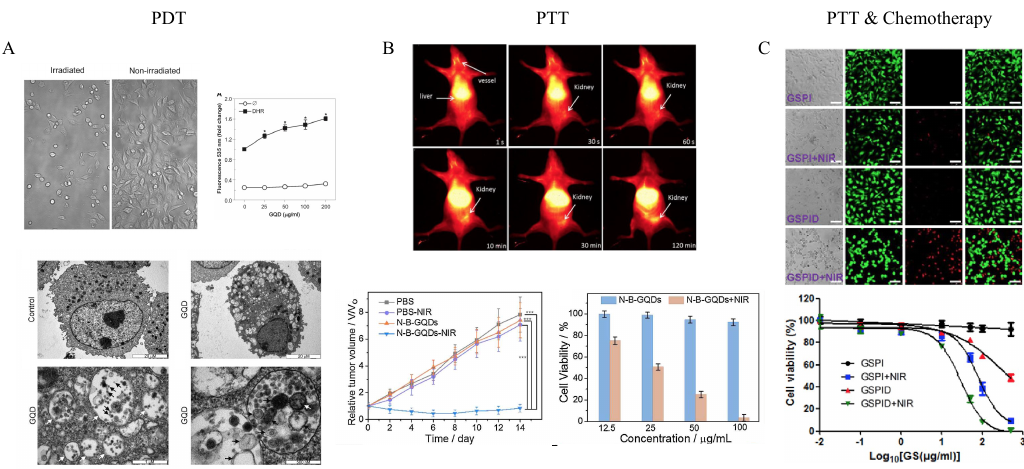
Figure 6. Phototherapy with GQDs. ( A ) Photodynamic therapy by irradiating U251 cells with blue light (470 nm), with relative ROS production (top) and autophagic vacuole formation (bottom, TEM). Adapted from [102]. Copyright 2012, permission from Elsevier; ( B ) NIR-II imaging (top) on xenograft C6 glioma mouse model and photothermal therapy (bottom), showing tumor growth reduction (in vivo) and loss in cell viability (in vitro). Adapted from [100]. Copyright 2019, permission from Elsevier; ( C ) Combination of PTT and chemotherapy with doxorubicin. GSPI = functionalized graphene sheets; GSPID = graphene sheets loaded with doxorubicin. Reprinted with permission [109]. Copyright 2013, American Chemical Society. Scale bar 75 µm.